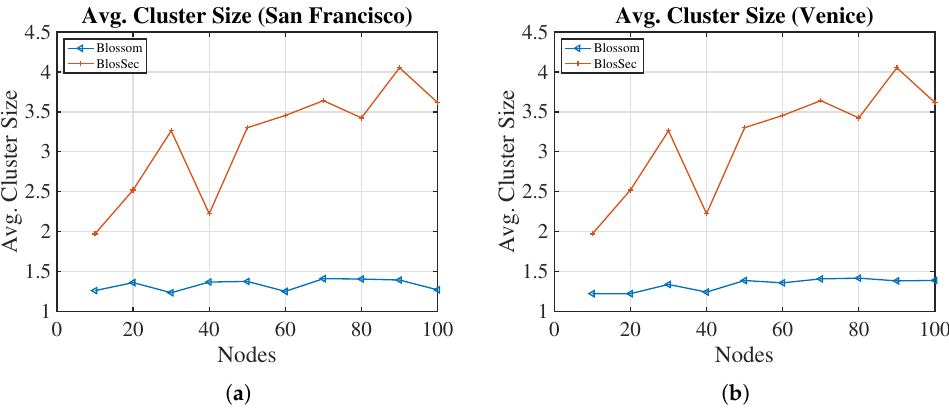
Figure 9. Comparison of Blossom against BlosSec on avg. maximum cluster size. ( a ) San Francisco; ( b )